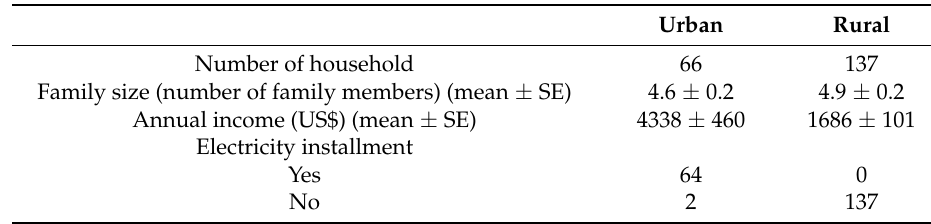
Table 1. Household characteristics in urban and rural areas of Yedashe Township. Data of the rural area were obtained from Win et al.